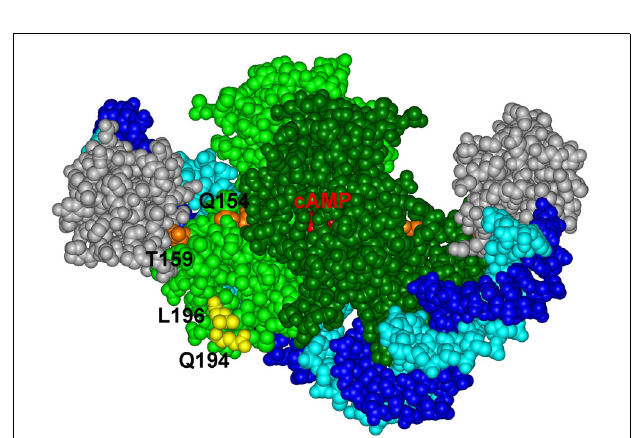
FIGURE 5 | Both half sites of the E. coli CRP-S site are required for Sxy dependent induction, but the orientation of the site has no effect. (A) Schematic drawing of the P sxy - lacZ reporter region in plasmid pMJ2532 (Jaskolska and Gerdes, 2015), and of its variants differing in the CRP-S half sites. The promoter proximal half-site is marked P and the promoter distal half-site is marked D. (B) Activity of the P sxy - lacZ reporter in the four different constructs in MG1655 (cid:49) lac cells with or without Sxy expression from plasmid pES251.